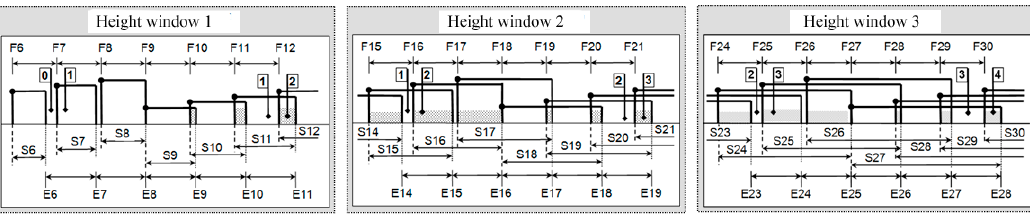
Electronics 2019 , 7 , x FOR PEER REVIEW Figure 1. Height dependence of the formation and dissolution of unstable height pulses.